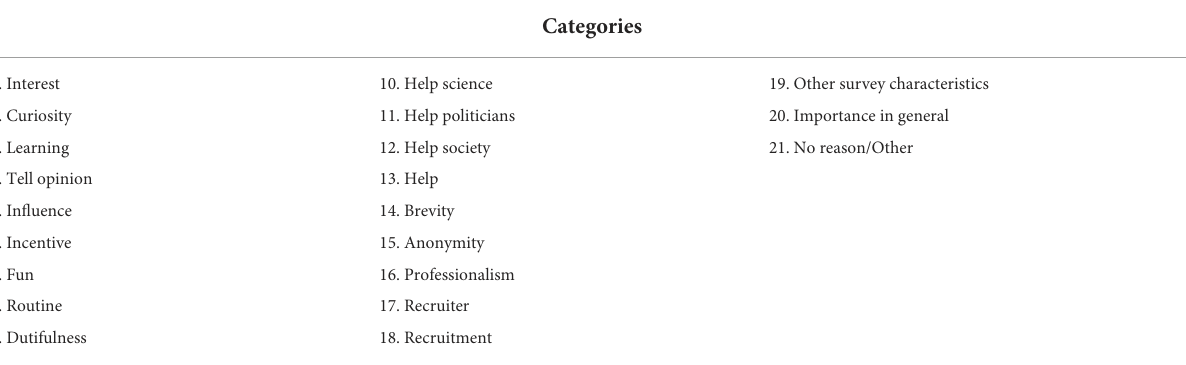
TABLE 1 List of categories for respondents’ motivation to participate in the GESIS